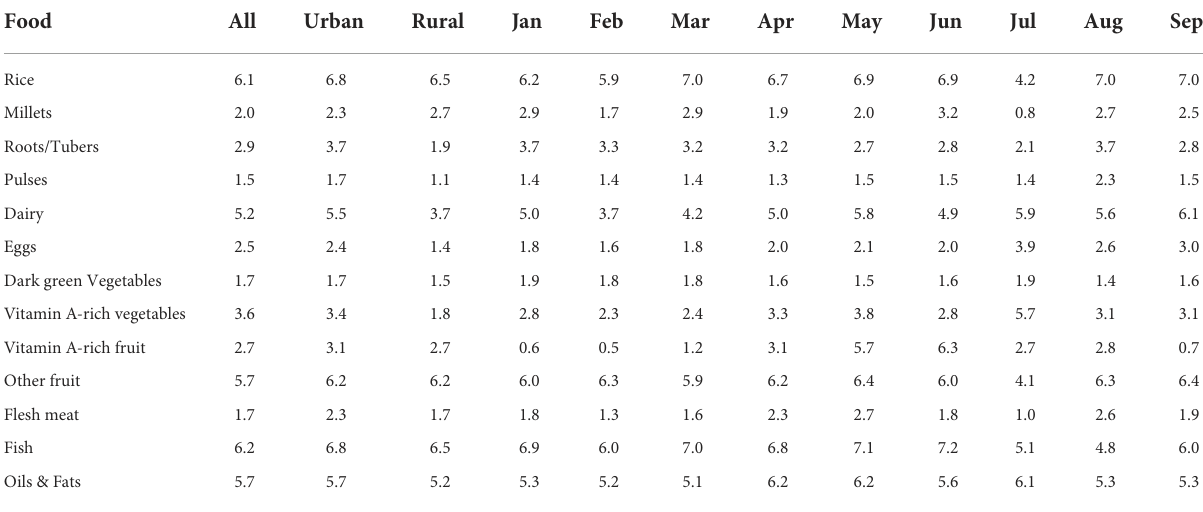
TABLE 5 Main Food consumption patterns by location and month.